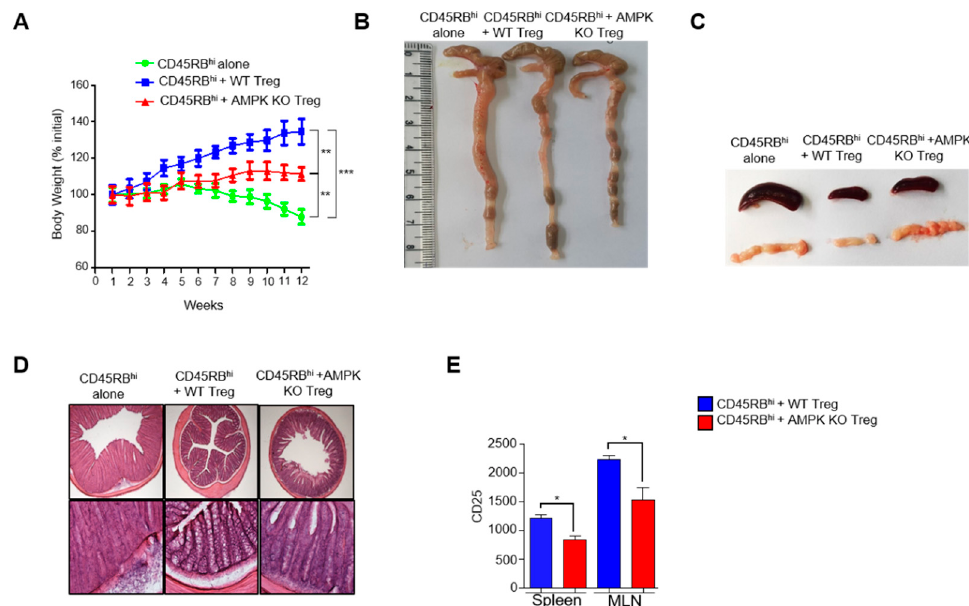
Figure 6. AMP-activated protein kinase (AMPK) supports suppressive activity of regulatory T cells (Tregs). Adoptive transfer of CD45RB hi alone, CD45RB hi + WT Tregs, and CD45RB hi + KO Tregs in the disease phenotype of 6-week-old Rag − / − mice and ( A ) measurement of change in body weight of the recipients ( n = 5 mice per group). ( B ) Representative photos of the colon of each group. ( C ) Representative image of the spleen and mesenteric lymph nodes (MLN). ( D ) Photomicrograph of hematoxylin and eosin (H&E) staining of colon sections of each group; upper row 40× (Scale bar 500 μ m) and lower row enlarged to 100× (Scale bar 200 μ m). ( E ) Bar diagram representation of the flow cytometric analysis of MFI of CD25+ cells gated from CD4 + cells isolated from the spleen and MLN of CD45RB hi + WT Tregs and CD45RB hi + KO Tregs. * p < 0.05, ** p < 0.01, *** p < 0.001 and n.s means non-significant ( p > 0.05).